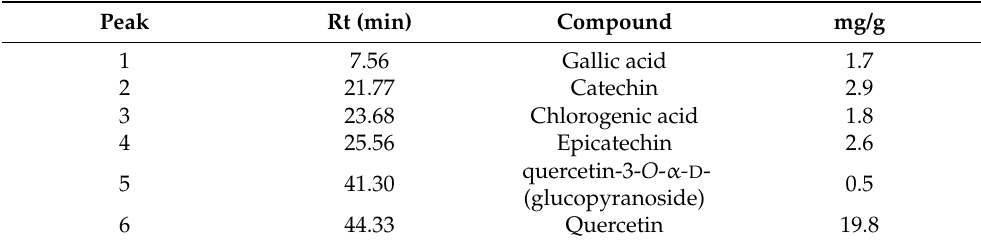
Figure 2. HPLC-DAD chromatogram of MeOH/H 2 O 80% extract of R. gallica var. aegyptiaca leaves. The figure shows the chromatographic separation of phenolic compounds based on the following conditions: Column, Zorbax C 18 , 5µm, 280 × 4.6 mm i.d.; detection at 350, 325, and 280 nm; flow rate, 0.5 mL/min; gradient elution system of methanol/water/formic acid; injected volume, 10 µL. Peaks: (1) gallic acid; (2) (+) catechin; (3) chlorogenic acid; (4) (–) epicatechin; (5) quercetin-3- O -α- D -(glucopyranoside); (6) quercetin; (*) unknown peaks. Table 3. Identification and quantification of the phenolic compounds present in MeOH/H 2 O 80% leaf extract of R. gallica var. aegyptiaca via HPLC-DAD.